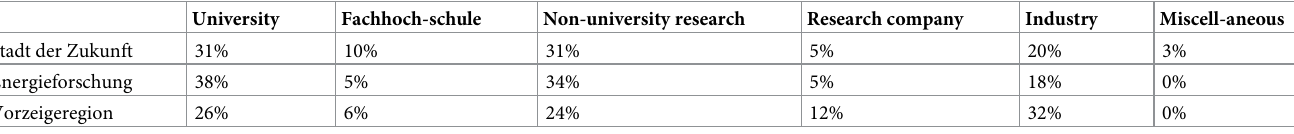
Table 1. Share of project leads per partner